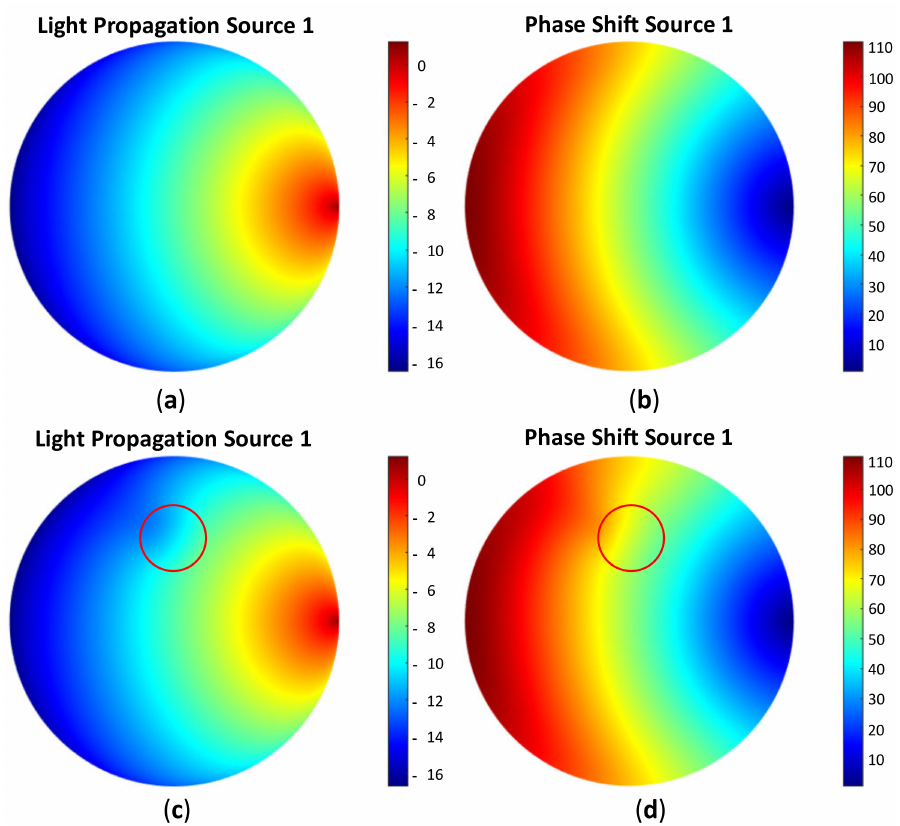
Figure 7. Distribution of ( a ) light propagation and ( b ) phase shift for homogeneous case; ( c ) light propagation and ( d ) phase shift for heterogeneous case, as in Figure 6b with the red circle, which shows the inclusion position when S 1 was used as the